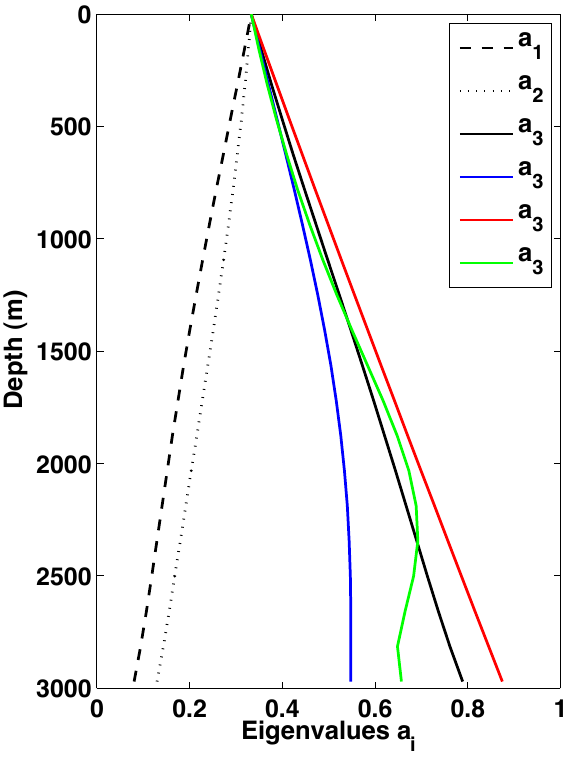
Fig. 9. Anisotropic steady-state simulation: Profiles of the eigen- values a 1 , a 2 and a 3 of the second-order orientation tensor a ( 2 ) at the Dome Fuji drill site. Black lines show profiles for standard values of the numerical diffusivity ( ν hor = 10 − 5 m 2 s − 1 , ν vert = 10 − 6 m 2 s − 1 ) , while the red and green lines show profiles of a 3 only for 10 times larger ( ν hor = 10 − 4 m 2 s − 1 , ν vert = 10 − 5 m 2 s − 1 ) and 10 times smaller ( ν hor = 10 − 6 m 2 s − 1 , ν vert = 10 − 7 m 2 s − 1 ) diffusivities, respectively. The blue line shows the profile of a 3 for standard values of the numerical diffusivity, but with a zero-gradient basal boundary condition for all elements of a ( 2 ) instead of Eq.